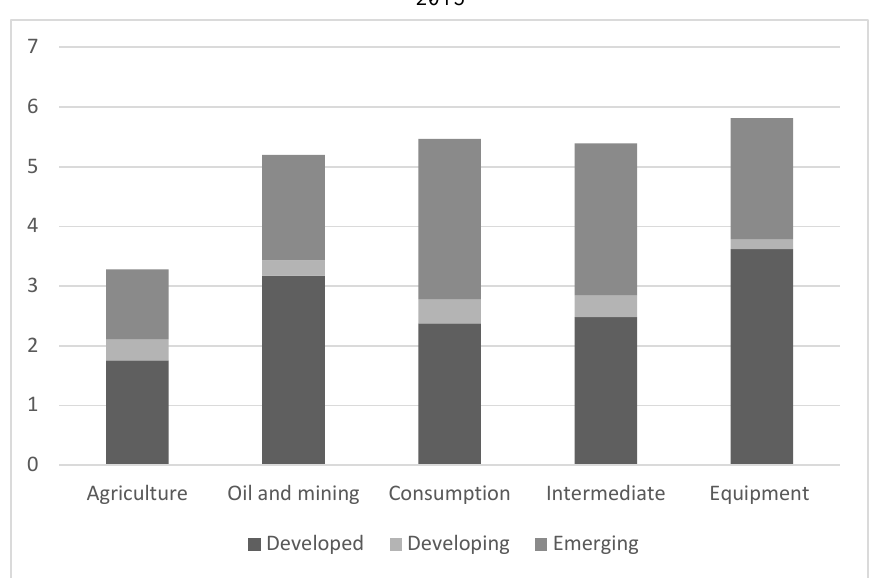
Figure 2 : Latin America: trade by products and group of trading partners (% of GDP), average 1989–